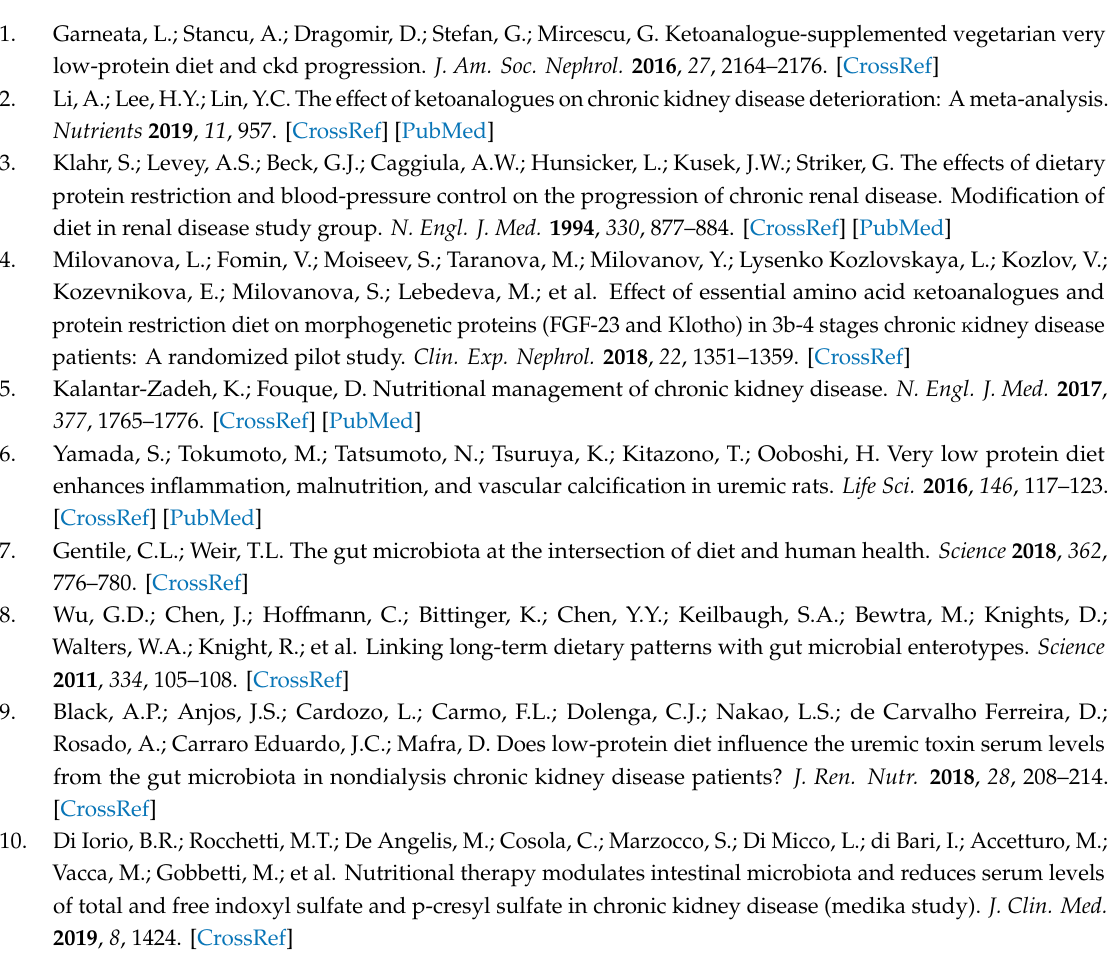
Table S1: Changes of serum SCFA and MCFA concentration associated with di ff erent dietary regimens (Mean ± SD); Table S2: Changes of serum bile acids concentration associated with di ff erent dietary regimens (Mean ± SD); Figure S1: Study design and patient flow schema; Figure S2: Determinations of best discriminatory bacterial taxa associated with CKD-LPD. Best discriminatory taxa categorizing CKD-LPD were estimated by performing Random Forests analysis using the overall OTU ( A ) only genus-levels abundances ( B ) or only species-level abundances ( C ) datasets against the dietary regimens. Bacterial taxa that are most discriminatory were ranked in decremental order of their importances to the accuracy of the model. Importance was evaluated based on the mean decrease in accuracy of microbiota prediction when the relative abundance of each taxon was randomly permuted. LPD, low protein diet; NPD, normal-protein